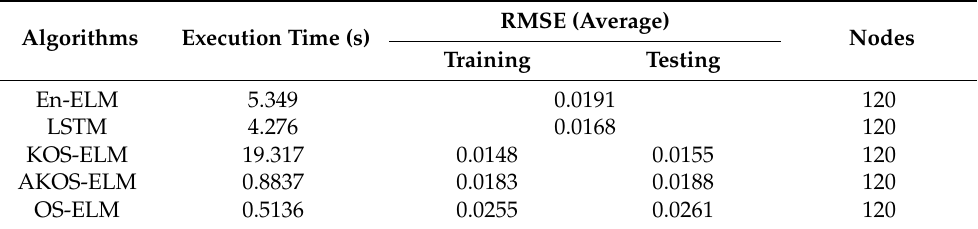
Table 2. Performance comparison of KOS-ELM, AKOS-ELM, OS-ELM En-ELM and LSTM on Level-3 sea condition.